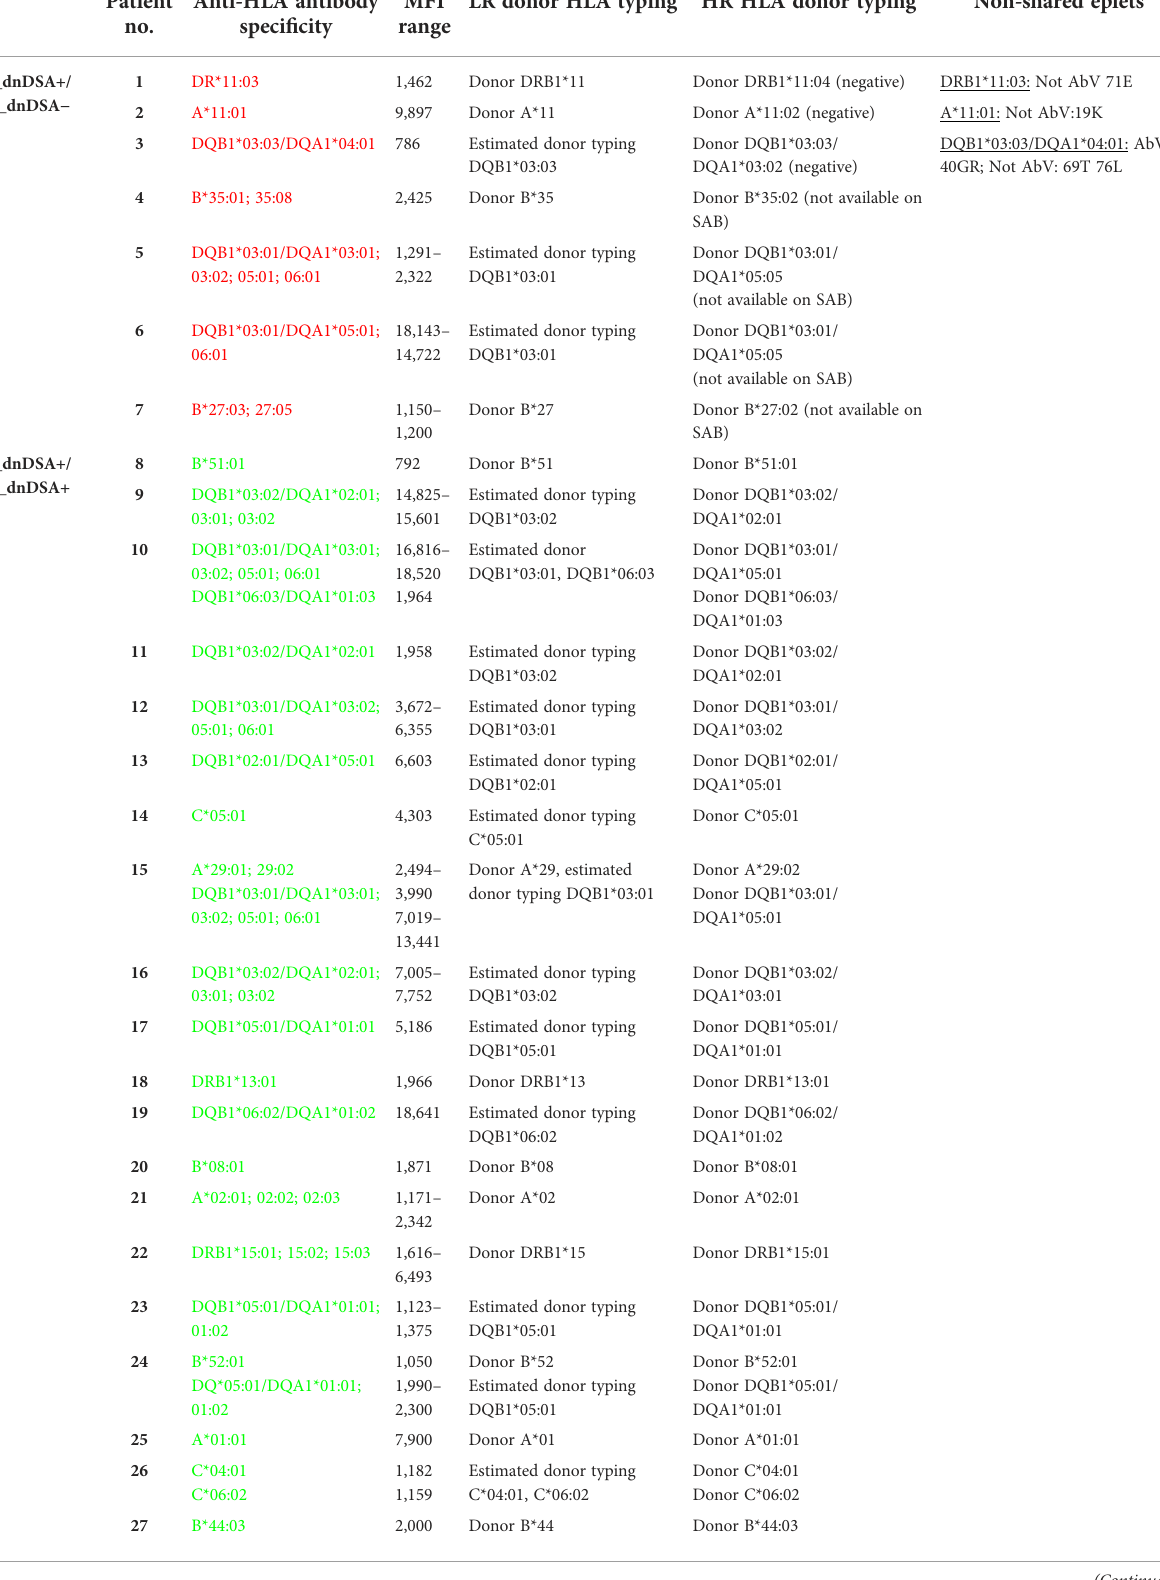
TABLE 3 All dnDSA speci fi cities detected by LR HLA typing and if con fi rmed or not by HR donor HLA typing. Patient